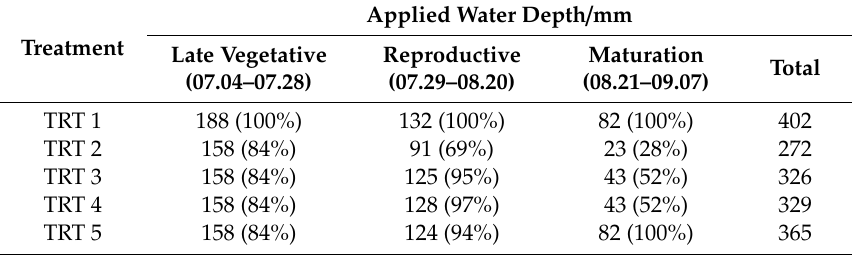
Table 1. Total applied water depth for each experimental treatment in the late vegetative, reproductive, and maturation stages where (07.04–07.28), (07.29–08.20), and (08.21–09.07) are the dates of the di ff erent growth stages. The water amount includes that of irrigation and precipitation, and the percentage of full treatment is shown in parentheses.